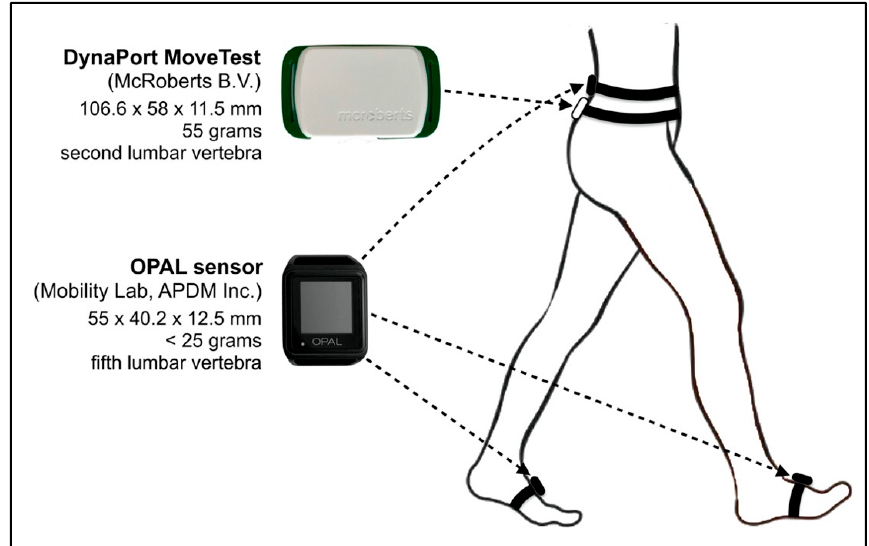
Figure 1. Placement of the DynaPort MoveTest and the OPAL sensors of the Mobility Lab.